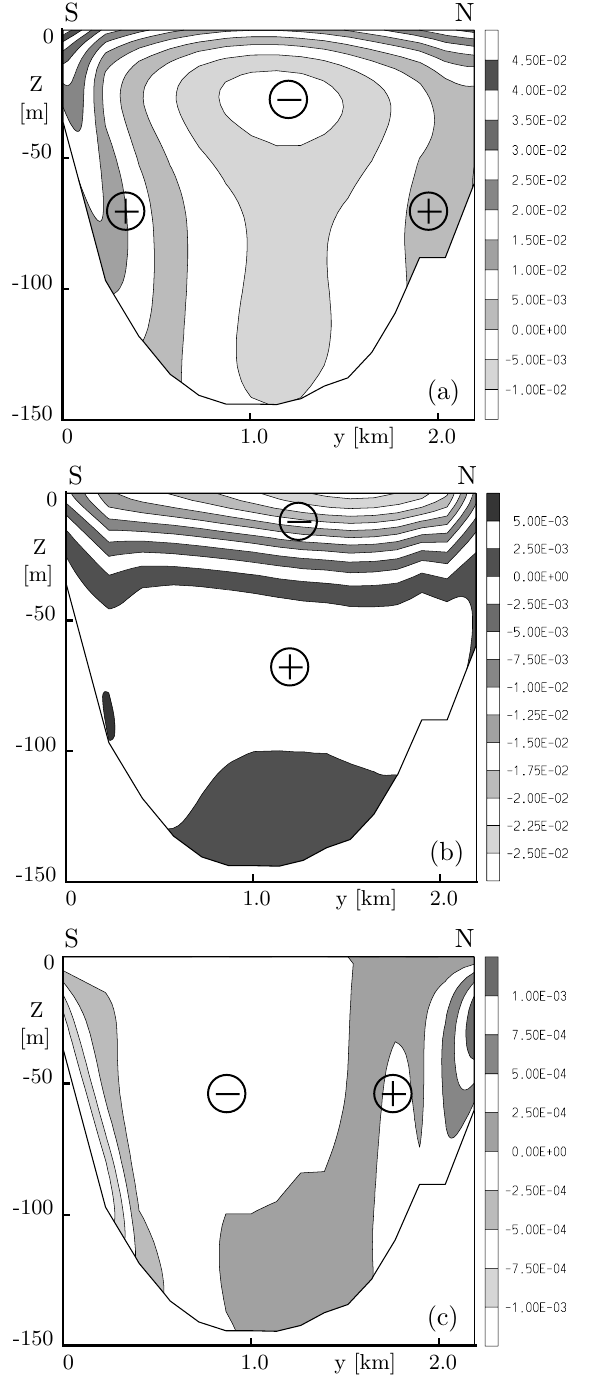
FIG. 17: Vertically integrated volume flux per unit width in the cross-sections of the center of the Fig. 16. Isotachs of the two horizontal and vertical velocity compo- ¨Uberlinger See (a) and in the Obersee (b) computed with the vertical eddy viscosity ν nents (a) u , (b) v and (c) w in a cross-section of the middle of the ¨Uberlinger See in steady state, subject to constant wind from 305 ◦ Broken curves indicate the transport part with the wind direction, dotted curves against the wind direc- NW approximately in the longitudinal direction (perpendicular to tion. The solid lines show the sum of the two. The location of the cross-sections is shown as inset. the plane of the graphs upwards) with the vertical eddy viscosity ν v = 0 . 02m 2 s − 1 .